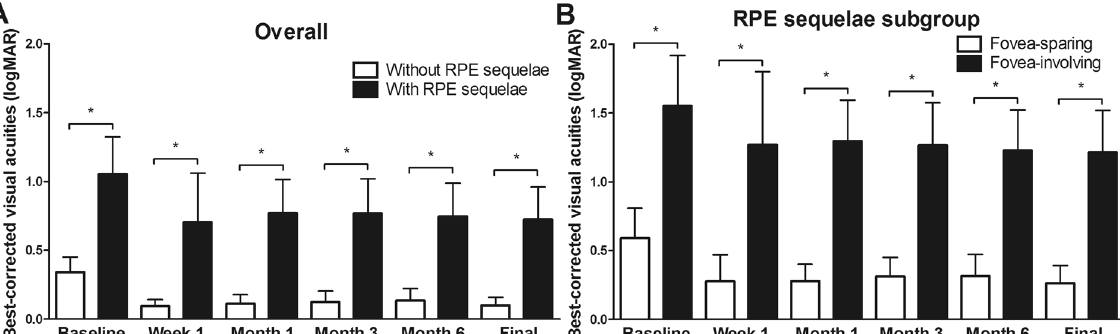
Figure 4. ( A ) Best-corrected visual acuities (BCVAs) over time in eyes with and without retinal pigment epithelium (RPE) sequelae and ( B ) those in eyes with fovea-sparing (non-foveal) and fovea-involving (foveal) RPE sequelae. At all baseline and follow-up visits, significant differences are noted in visual function between eyes with and without RPE sequelae, and between eyes with and without foveal involvement of RPE sequelae. Asterisk ( * ) indicates statistical significance. Error bars indicate upper bounds of 95% confidence